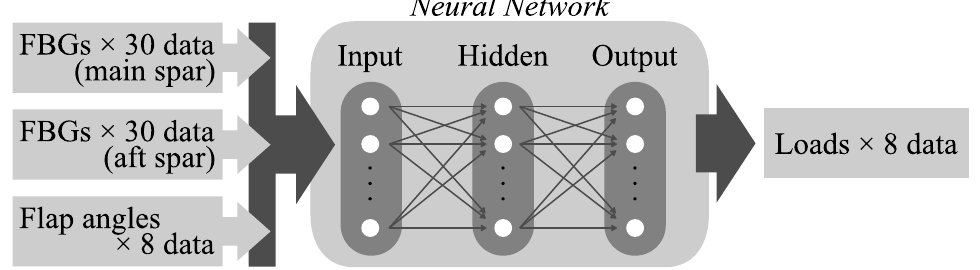
Figure 7. Architecture of neural network for load identification.